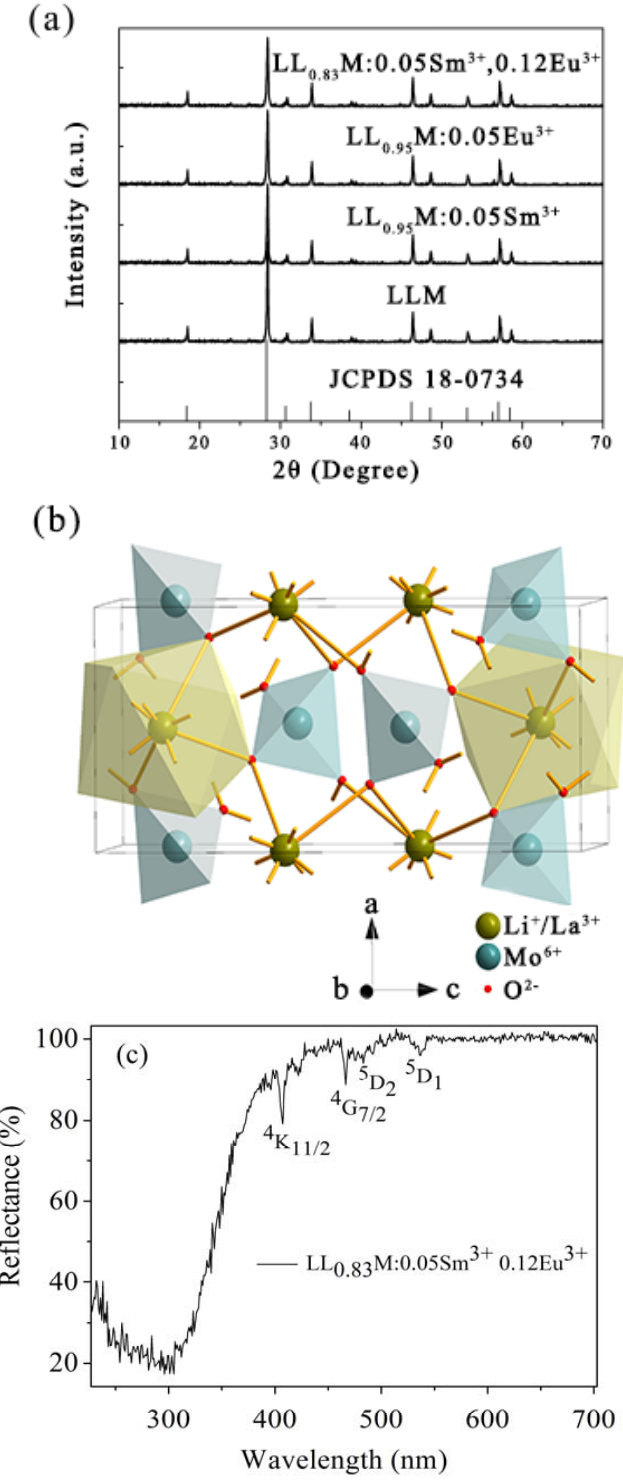
Figure 1. ( a ) The XRD (X-ray powder diffraction) patterns of LiLa(MoO 4 ) 2 , LiL 0.95 (MoO 4 ) 2 :0.05Sm 3+ , LiLa 0.95 (MoO 4 ) 2 :0.05Eu 3+ , LiLa 0.83 (MoO 4 ) 2 :0.05Sm 3+ ,0.12Eu 3+ samples with the standard data of LiLa(MoO 4 ) 2 (JCPDS No. 18-0734); ( b ) crystal structure of tetragonal phase LiLa(MoO 4 ) 2 ; ( c ) The diffuse reflectance spectrum of LiLa 0.83 (MoO 4 ) 2 :0.05Sm 3+ ,0.12Eu 3+ . Some locations of terminal J -multiplets of Sm 3+ and Eu 3+ transitions are marked. The electronic ground states are 6 H 5/2 (Sm 3+ ) and 7 F 0 (Eu 3+